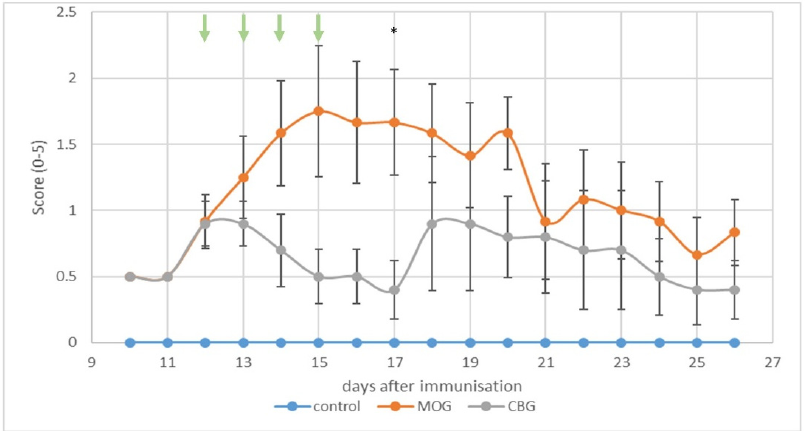
Figure 5. Evaluation of the clinical score over time of C57BL/6 female mice immunized with MOG. Mice were treated once a day with CBG (10 mg/kg) or vehicle (Tween 20:ethanol:saline; 1:1:8) for four consecutive days starting on day 12 p.i. (indicated by green arrows). The results are shown as mean ± SEM of the experimental groups (1 experiment n = 4–6 mice in each group). One-way ANOVA followed by Tukey–Kramer multiple comparison post-test was performed. * p < 0.05 vs. vehicle.